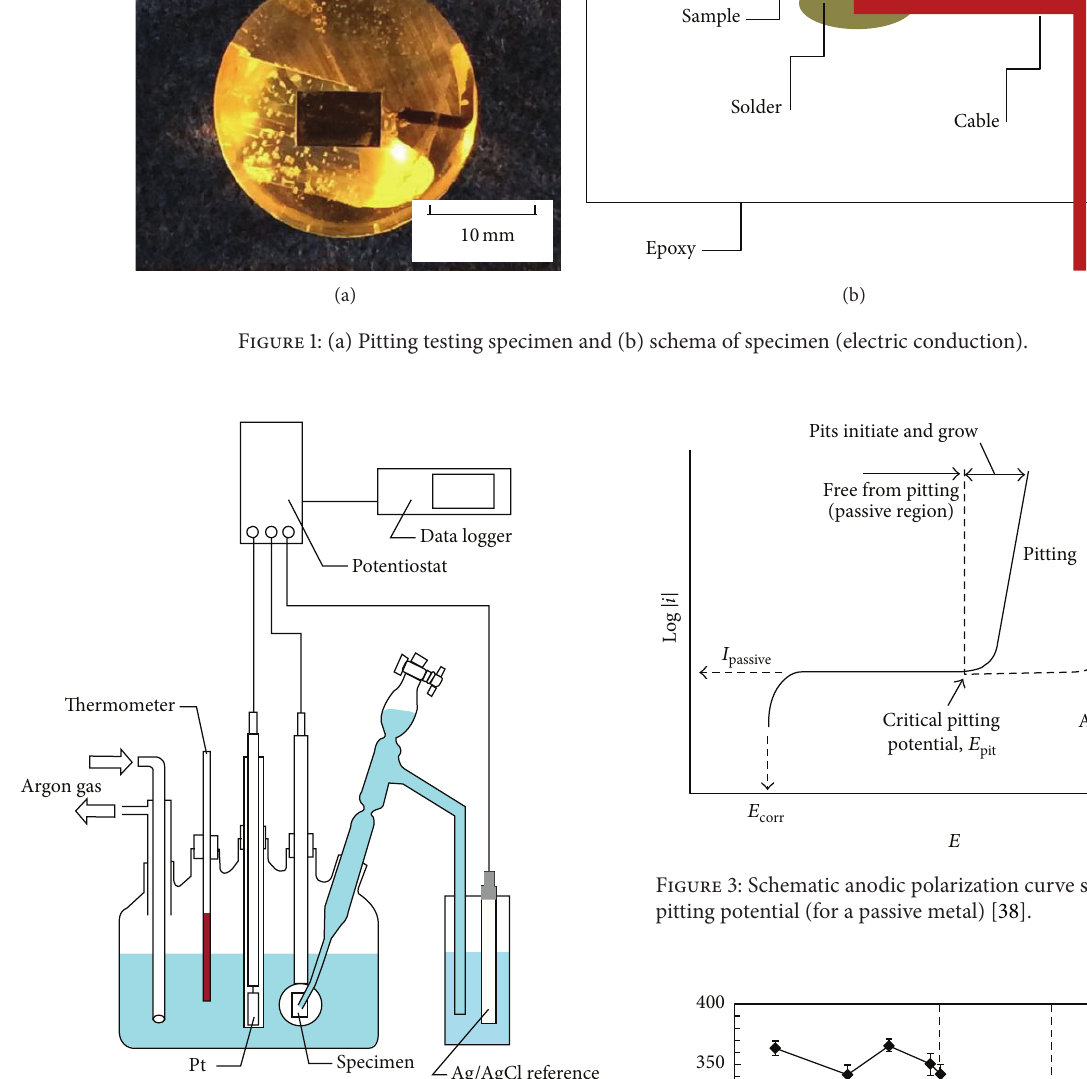
Figure 2: Schematic of pitting testing equipment arrangement.